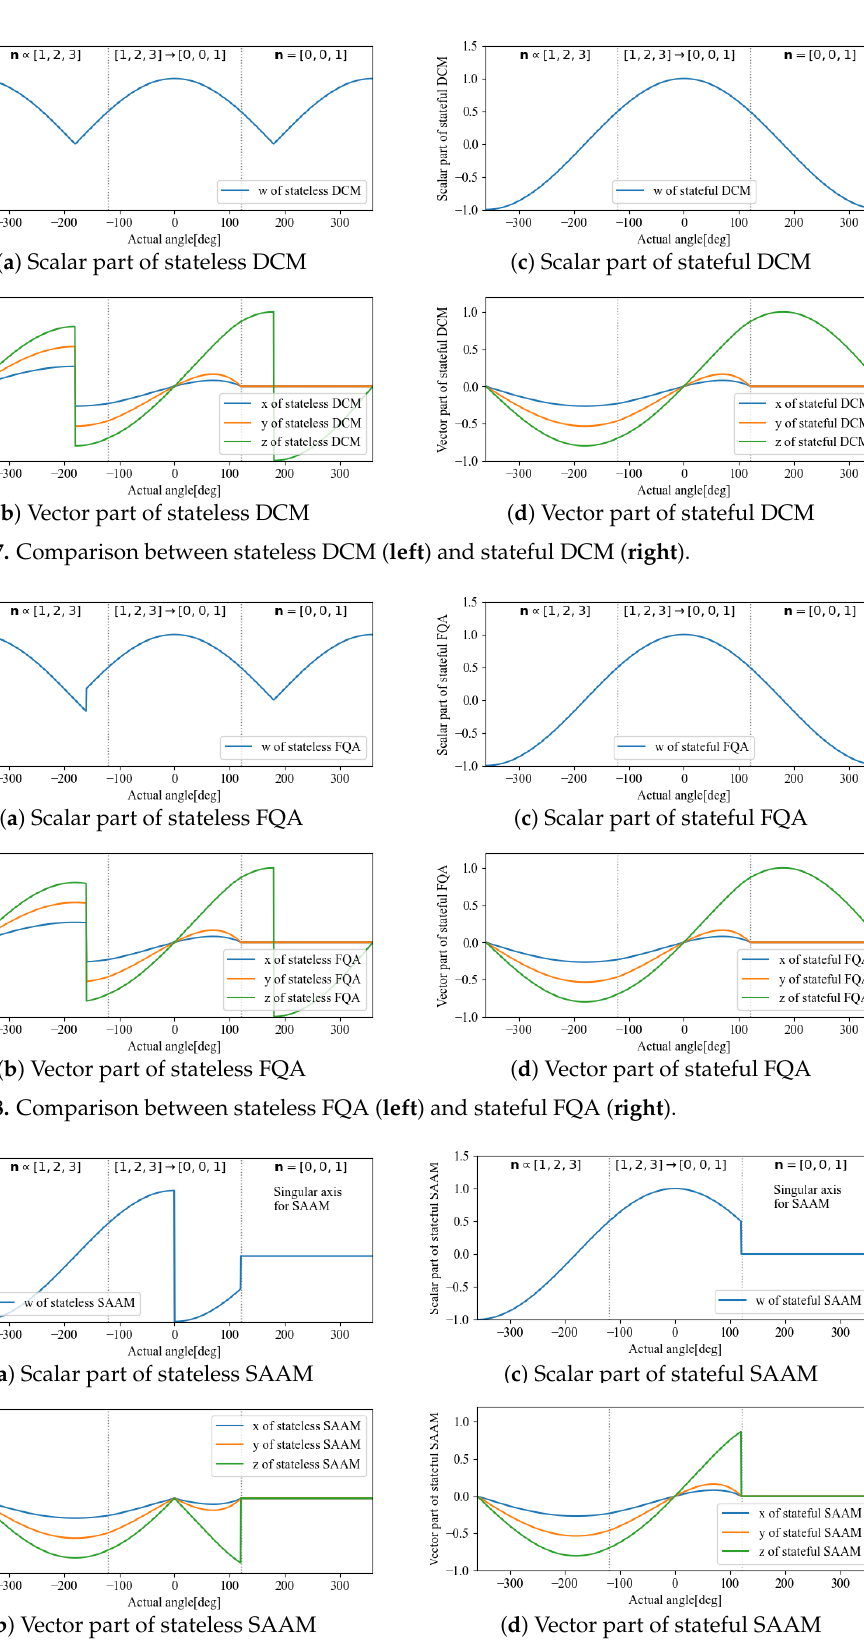
Figure 9. Comparison between stateless SAAM ( left ) and stateful SAAM ( right